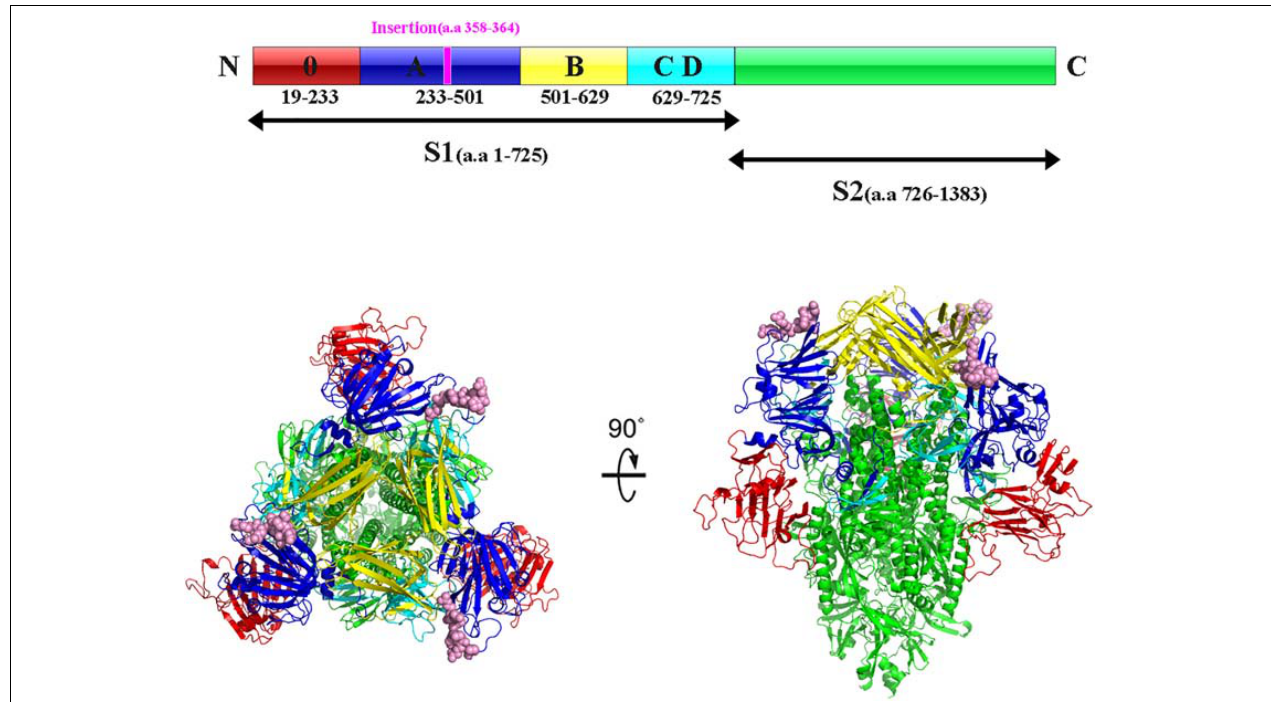
FIGURE 3 | Structure prediction of S protein of PEDV HNAY in the prefusion conformation. The primary sequence of PEDV S protein can be divided into S1 and S2. The S1 region can be further divided into S10, S1A, S1B, and S1CD (in red, admiral blue, yellow, and arctic blue, respectively). The 7-aa insertion was shown in purple within S1A domain. Viewing the trimeric PEDV HNAY S protein from the membrane distal apex and a 90 ◦ view based on the crystal structure of S protein of USA/Colorado/2013. S10, S1A, S1B, S1CD, and S2 were shown in red, admiral blue, yellow, and arctic blue, respectively, and the 7-AA insertion was in pink in the crystal structure